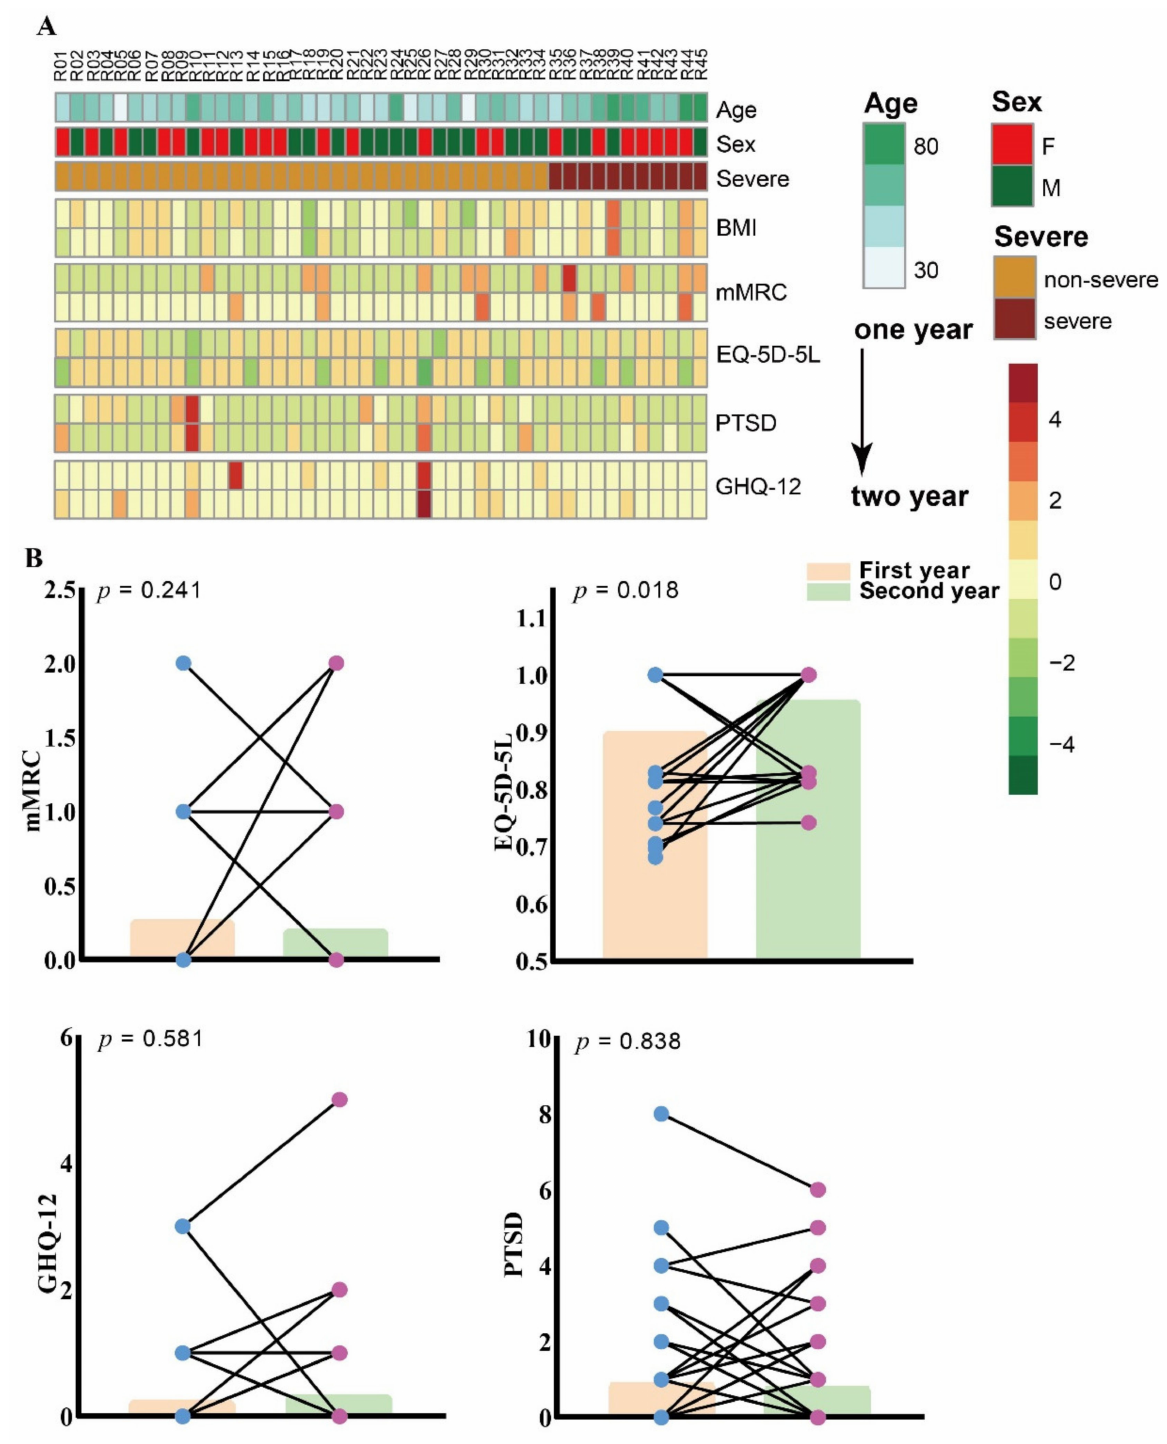
Figure 2. Changes in the mMRC, EQ-5D-5L, GHQ-12, and IES-R scores in the 45 recovered sub- jects. ( A ) Scores of each scale in two years for each subject. ( B ) The changes in each scale for recovered